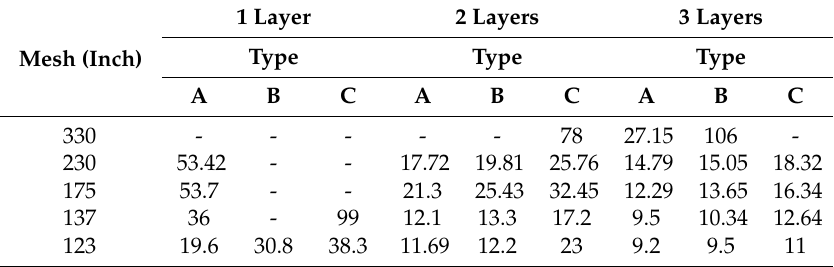
Table 5. Capacitance (pF) for OLD when 1–3 layers of D2081009D6 ink are used. 1 Layer Mesh (Inch)